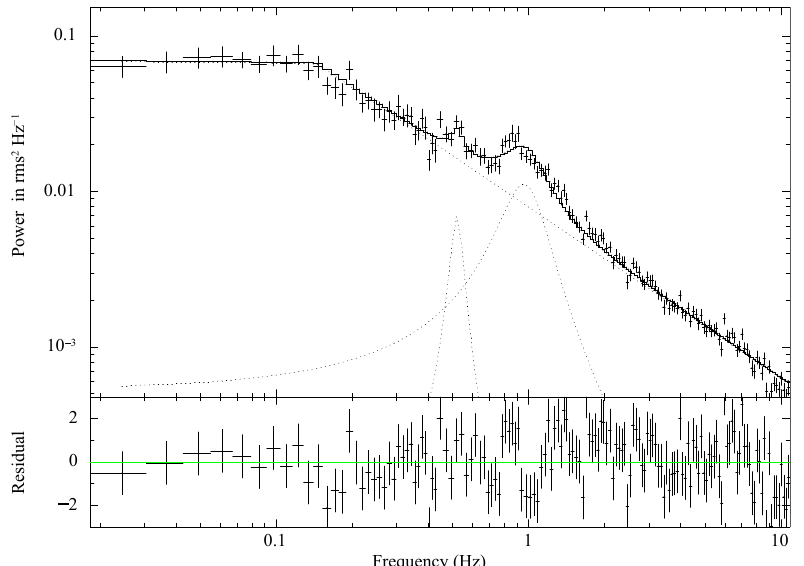
Figure 3. Continuum-fitted power density spectrum using 0.01 s time binned 3–80 keV As- troSat/LAXPC light curve from orbit 20064 of observation ID = T03_120T01_9000002990 with a QPO of frequency 0.96 ± 0.01 Hz along with a sub-harmonic at 0.52 ± 0.01